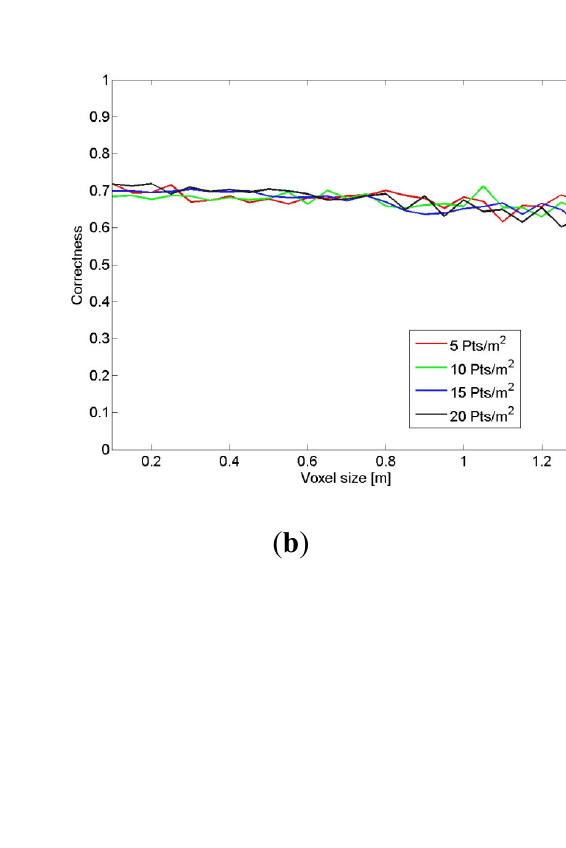
V for the dataset of Test Site Size